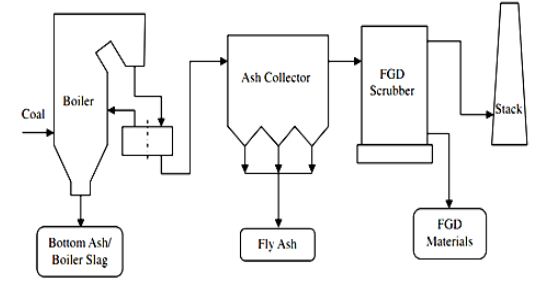
Fig. 1. Schematic diagram of coal combustion by